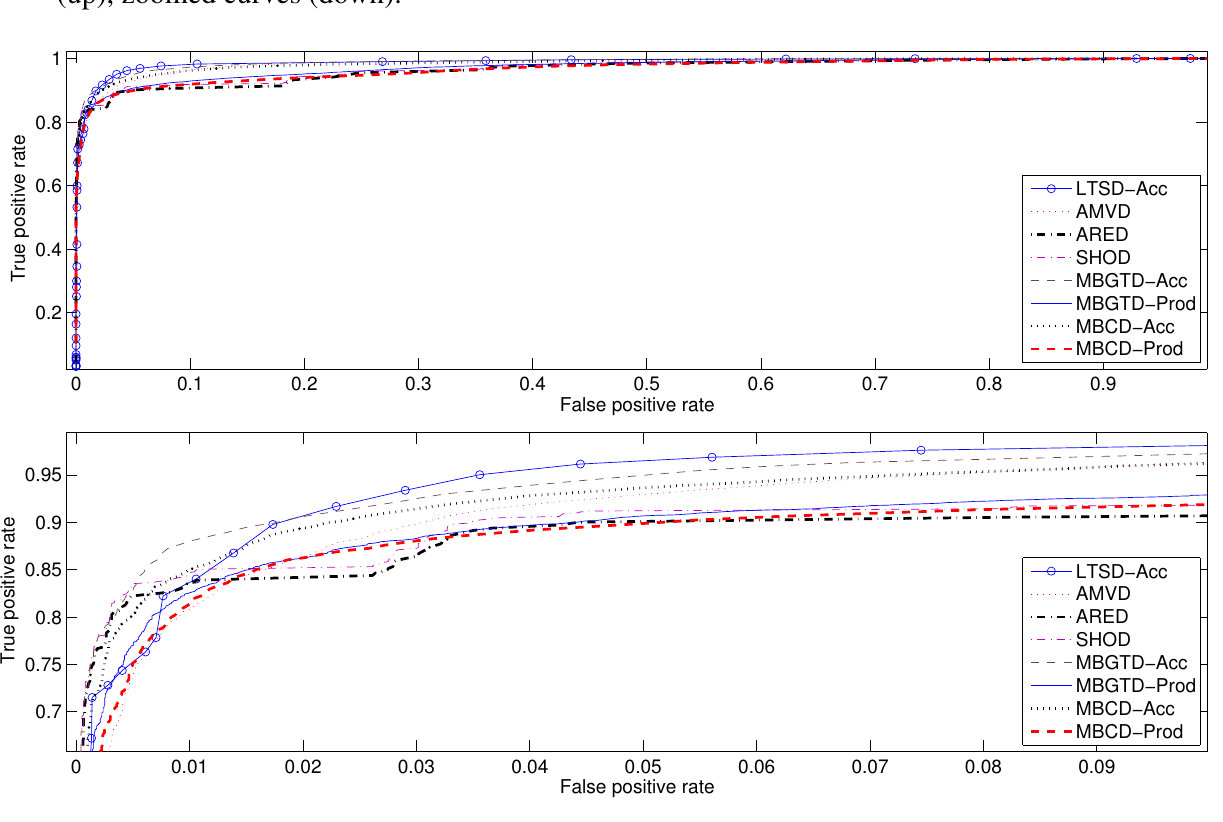
Figure 10. ROC curves computed for the eight best methods. Real signals. Complete curves (up), zoomed curves